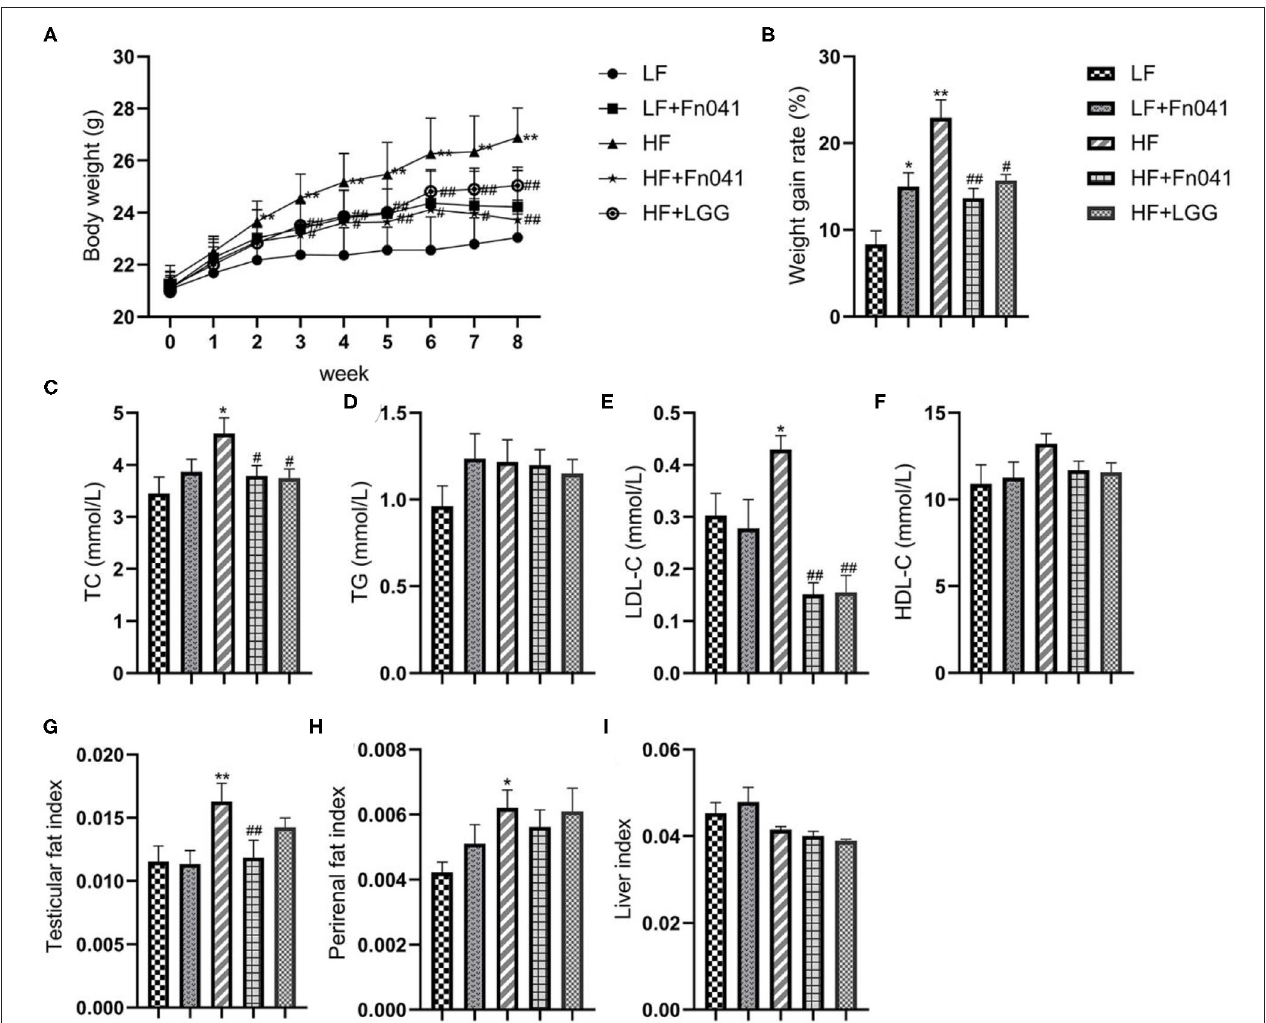
FIGURE 1 | Effect of Lactobacillus reuteri Fn041 on body weight, fat accumulation, and serum biochemical indexes in the high-fat diet mice. (A) Weight change; (B) The weight gain rate; (C) TC; (D) TG; (E) LDL-C; (F) HDL-C; (G) Testicular fat index; (H) Perirenal fat index; (I) Liver index. Data are presented as mean ± SEM ( n = 12/group); * p < 0.05, ** p < 0.01 as compared with the LF group; # p < 0.05, ## p < 0.01 as compared with the HF group. LF, low-fat diet group; LF + Fn041, low-fat diet group treated with L. reuteri Fn041; HF, high-fat diet group; HF + Fn041, high-fat diet group treated with L. reuteri Fn041; HF + LGG, high-fat diet group treated with Lactobacillus rhamnosus GG. HDL-C, high-density lipoprotein cholesterol; LDL-C, low-density lipoprotein cholesterol; TC, total cholesterol; TG,